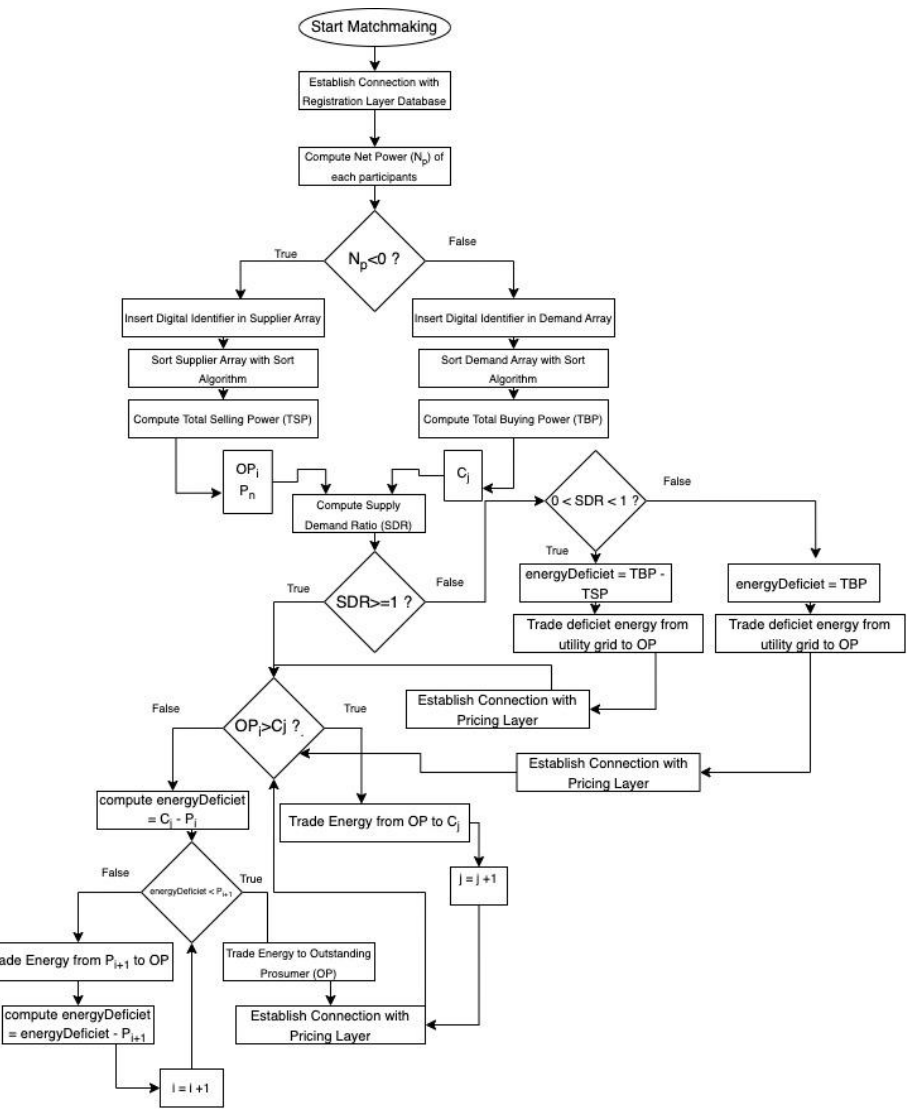
Figure 5. Matchmaking peer-peer for energy trading .